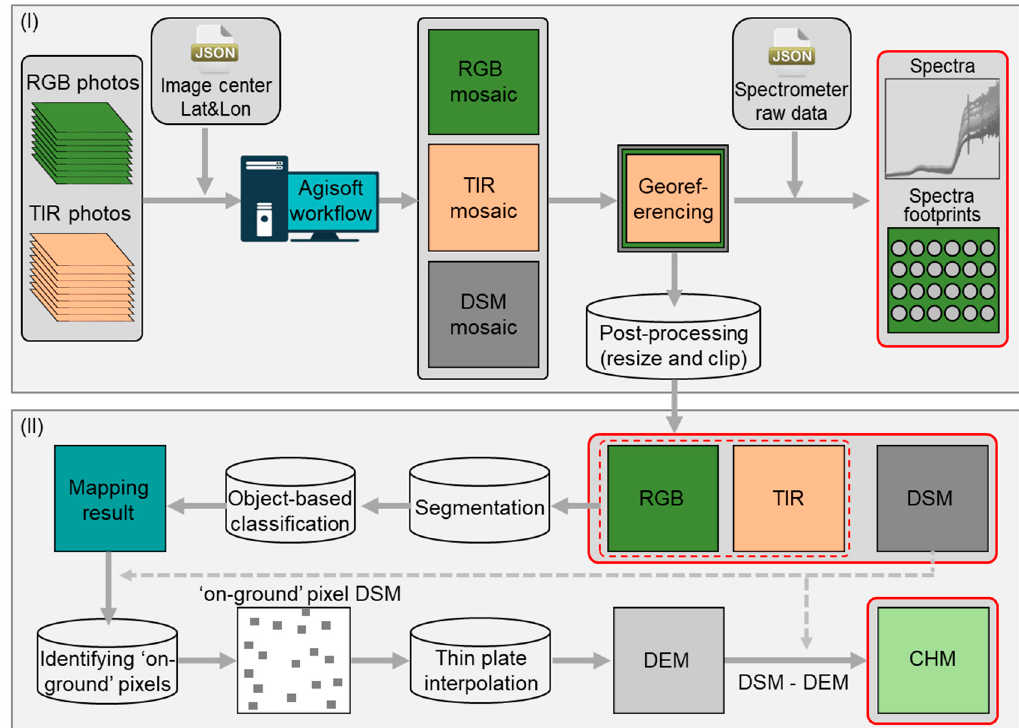
Figure 3. The proposed workflow for the Osprey data processing. ( I ) Processing of Osprey raw collections to generate ortho-mosaicked optical RGB and thermal infrared (TIR), digital surface model (DSM), and spectral data (including spectral reflectance and spectra footprints). ( II ) The proposed method for deriving the canopy height model (CHM) using image classification and thin plate interpolation. The thick red boundary indicates the outputs of this workflow.